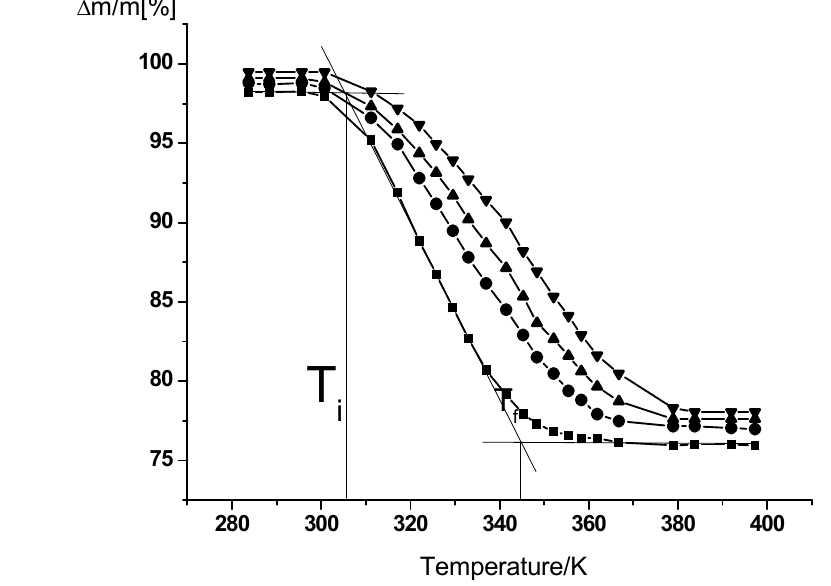
Figure 1 – The TG curves for the desorption of ethanol from CMS at various